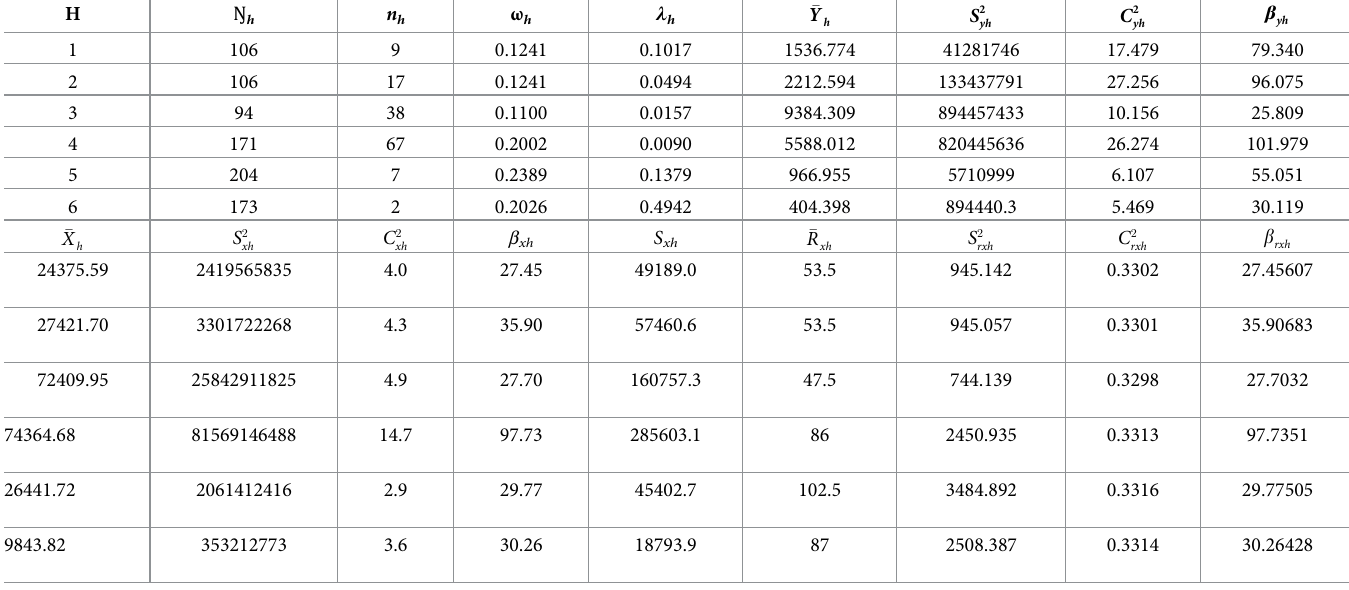
Table 4. Summary statistics of Population